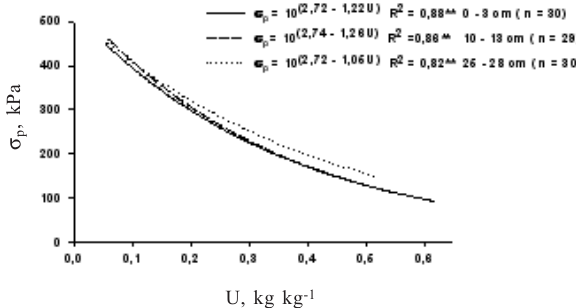
Figura 1. Modelos da capacidade de suporte de carga para o Latossolo Amarelo distrófico típico nas camadas de 0–3, 10–13 e 25–28